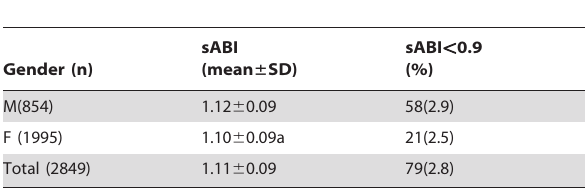
Table 5. Comparison of sABI between two gender groups.